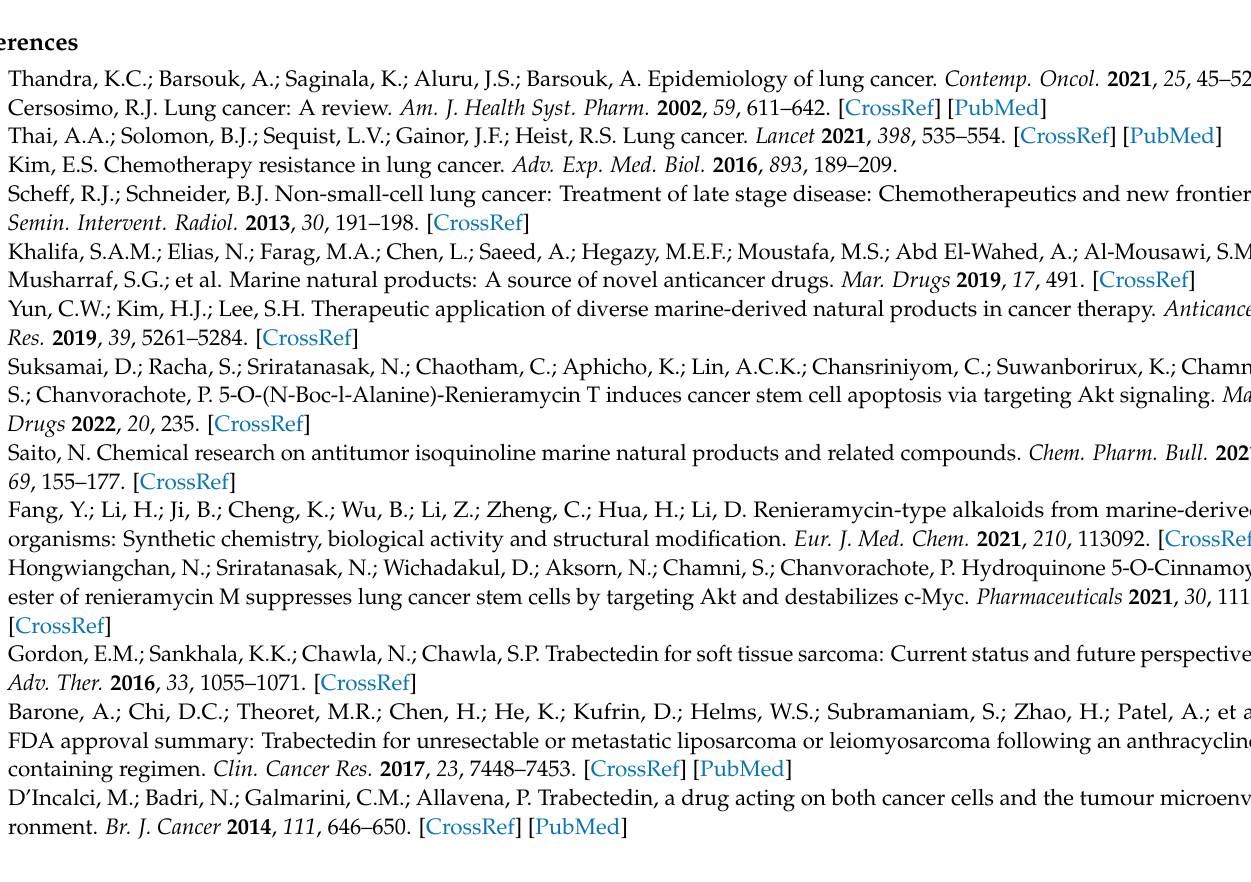
Figure S3: High resolution-ESI-MS of 22-(4 (cid:48) py)-JA; Figure S4: Purity analysis of 22-(4 (cid:48) py)-JA by LC-MS; Figure S5: Apoptosis signaling pathway (hsa04210) constructed by the KEGG database; Figure S6: Cytotoxicity of 22-(4 (cid:48) py)-JA in normal lung epithelial BEAS-2B cells; Figure S7: The effect of 22-(4 (cid:48) py)-JA and JA on caspase-3 activation; Table S1: List of potential targets of 22-(4 (cid:48) py)-JA from SwissTargetPrediction; Table S2: Core targets of 22-(4 (cid:48) py)-JA against non-small-cell lung cancer were ranked according to the degree